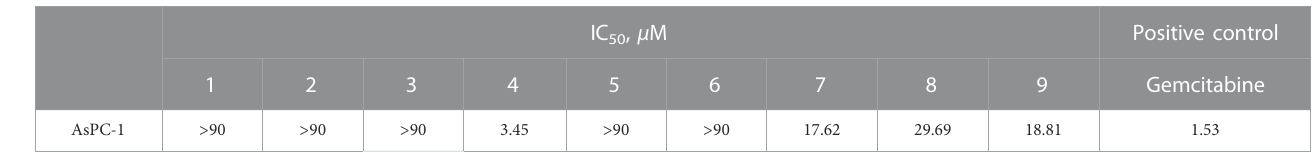
TABLE 2 Cytotoxicity of compounds 1 – 9